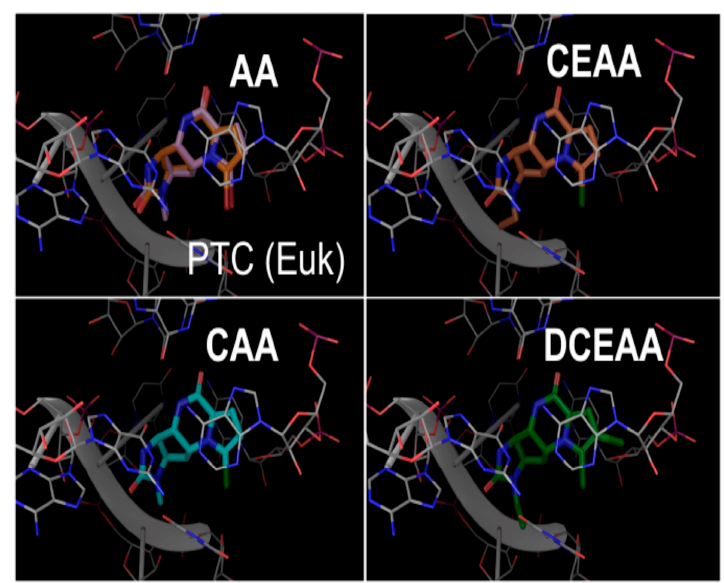
Figure 5. Euk ribosome bound by AA analogues. Top Left: Side-by-side comparison of recently published AA crystal structure (PDB code: 5MEI) (Orange) and our AA docked (Pink) in Euk ribosome, Bottom Left: Docking position of CAA in Euk ribosome (Cyan), Top Right: CEAA (Orange) is the strongest binder with Euk ribosome, Bottom Right: DCEAA (Green) and PAA (not shown) for negative control docked in Euk ribosome. A complete depiction for all AA analogs docked with ribosome PTC is given in Figure 4.